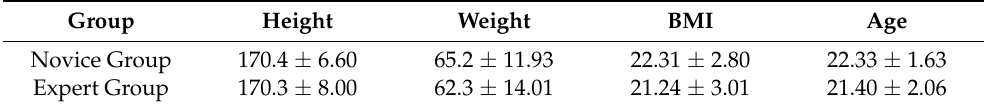
Table 1. Demographic Information Tables. Group Height Weight BMI Age Novice Group 170.4 ±